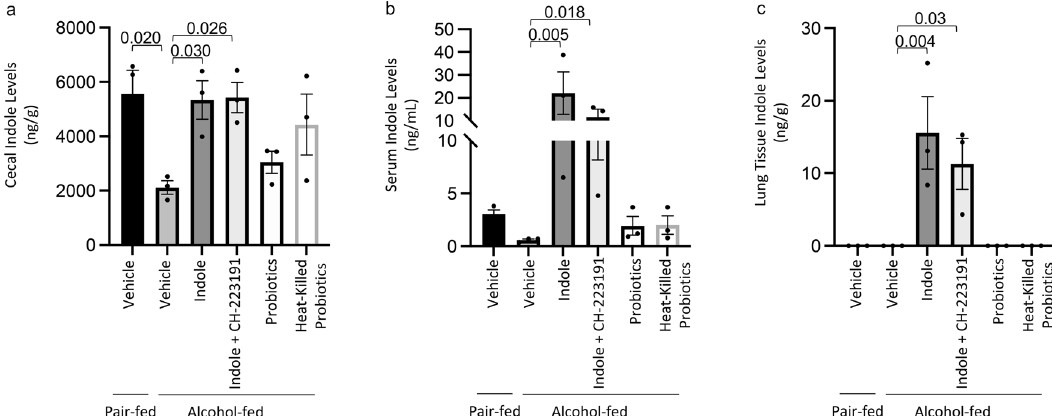
Fig. 7 Cecal, serum, and lung Indole concentrations. Binge-on-chronic alcohol-fed mice with and without treatment were infected with Klebsiella and sacri fi ced 48 h post-infection and the indole concentrations in the a cecum, b serum, and c lung tissue were determined. Bars represent the mean ± SEM and dots represent individual mice. P values are indicated in the fi gure and were determined by one ‐ way ANOVA with Sidak ’ s multiple comparison test. N = 3/group.